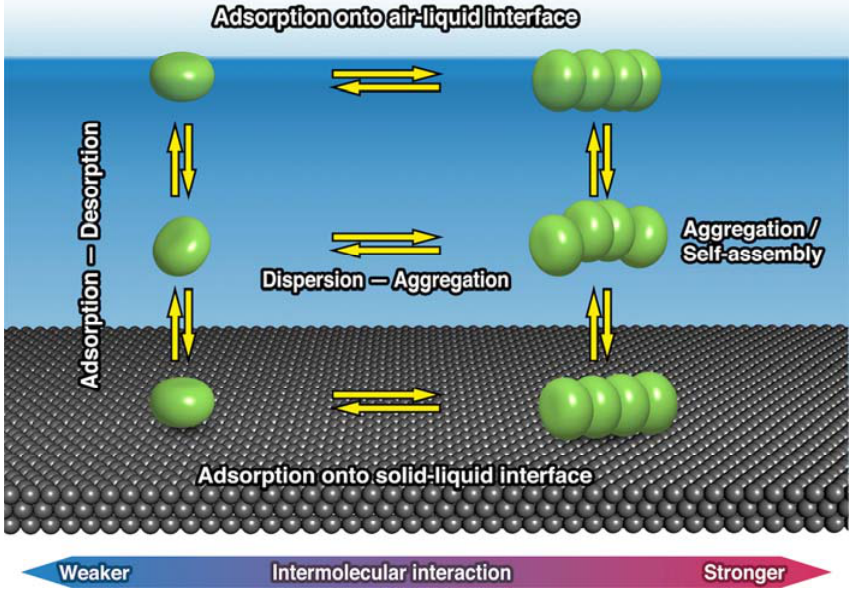
Figure 1. Thermodynamic equilibriums between a homogeneous solution, an air–liquid interface and a solid–liquid